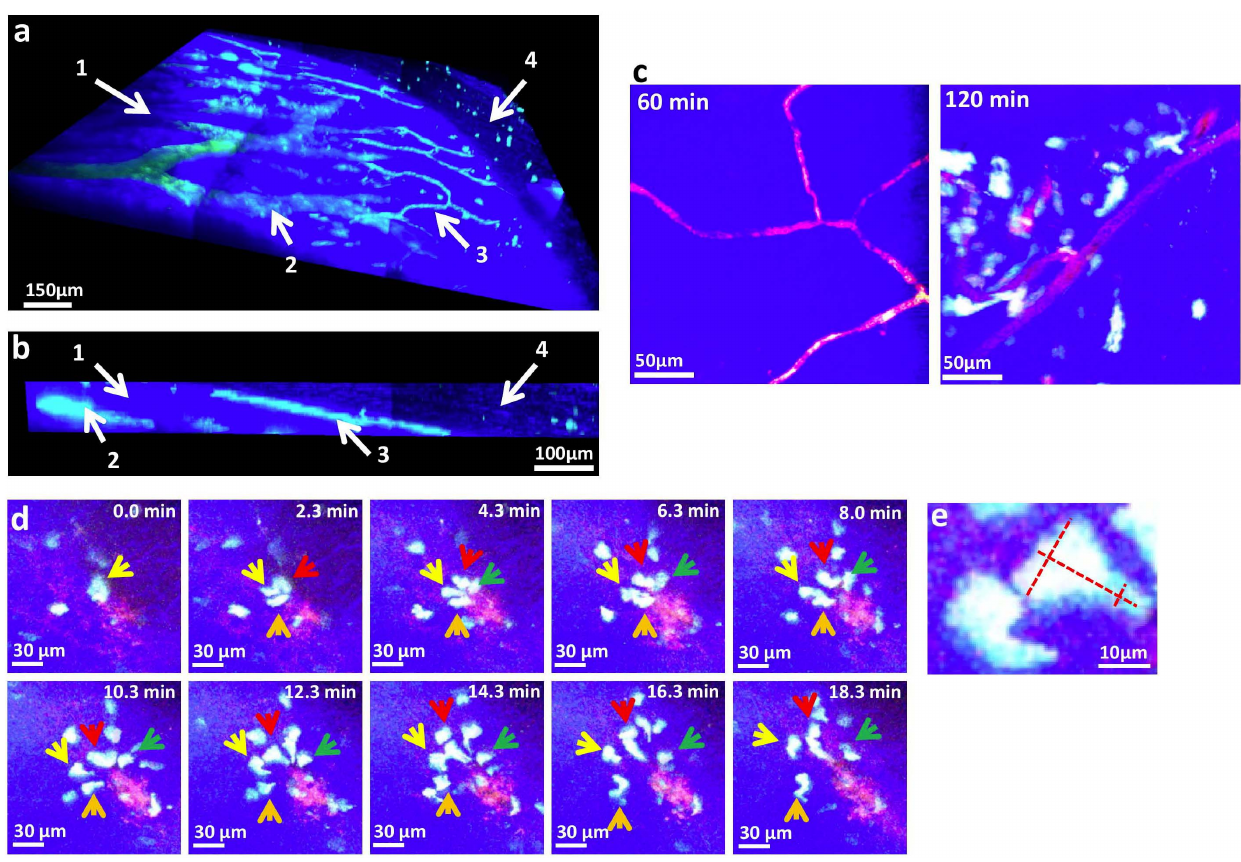
Figure 4. ECFP + monocytes infiltrated the wound bed through areas of microhemorrhages. ( a ) Front and ( b ) transversal TPLSM 3D reconstruction of the wound site in MacBlue 6 CX3CR1 gfp/ + mice 30 min post-wounding. 70 kDa fluorescein-dextran (green) was injected i.v . before the imaging session for vasculature staining. The SHG signal is in blue. Legends represent: 1 : Skull, 2 : Bone marrow vasculature, 3 : Superficial vasculature, 4 : Deep skin layer. ( c ) TPLSM pictures at different time point after wounding of MacBlue 6 CX3CR1 gfp/ + mice. Vasculature staining was performed with high molecular weight (2 MDa) rhodamine-dextran (red). The ECFP signal is in cyan. ( d ) Time lapse image series representing monocyte (arrows) egress from a microhemorrhage area toward the wound bed. Colored arrows depict 4 distinct infiltrating monocytes. ( e ) Representative ECFP + cell morphology during egress from the blood.